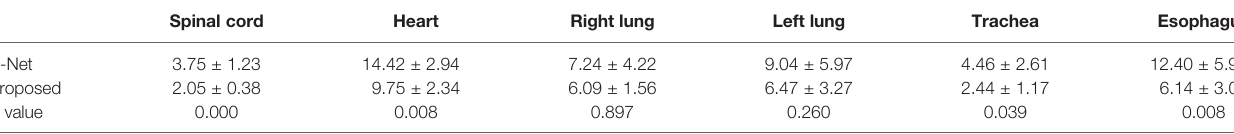
TABLE 3 | Comparison of HD95 (mm) of two models ( (cid:2) x ± s ). Spinal cord Heart